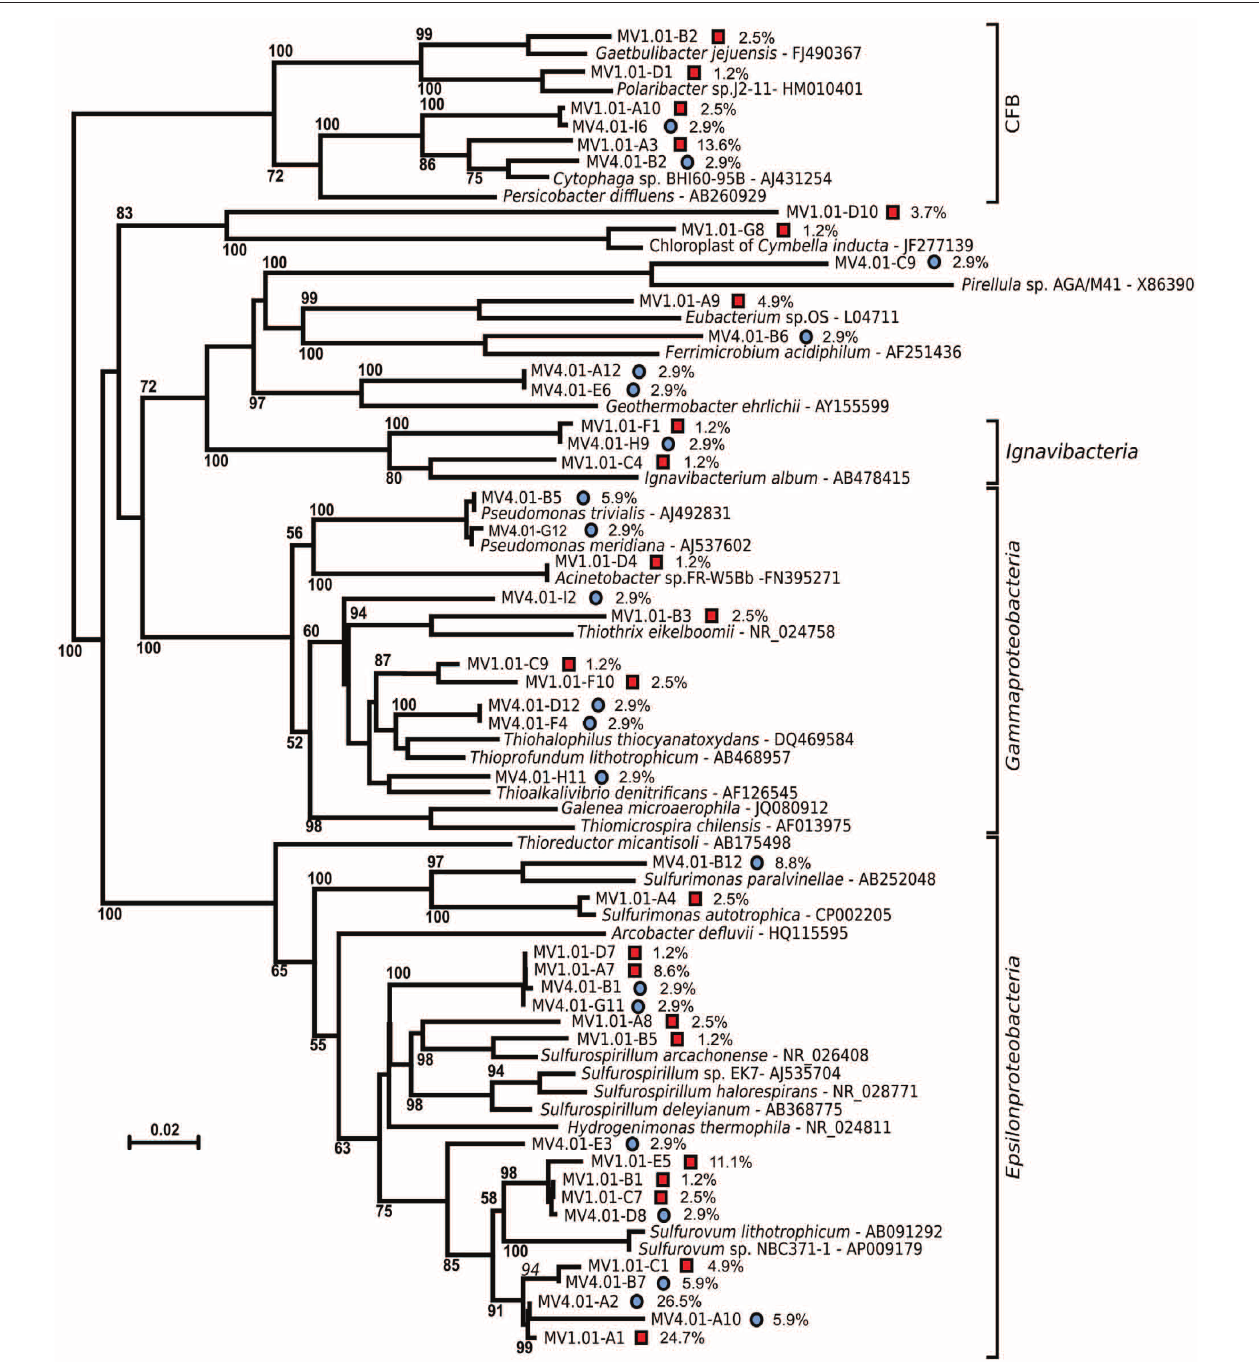
FIGURE 5 | Unrooted Neighbor-joining tree of the bacterial diversity at station MV1 (red squares) and MV4 (blue circles) surface sediments (0–1cm) with cultured relatives. The tree was obtained using Jukes–Cantor